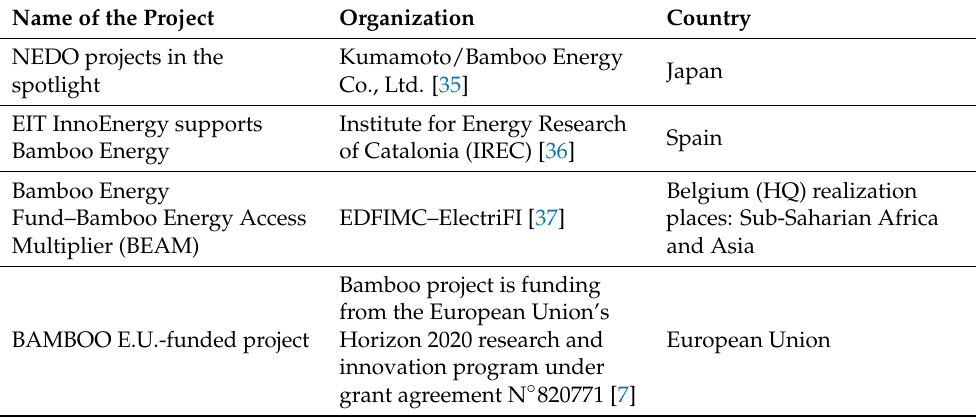
Table 3. Selected projects concerning energy from